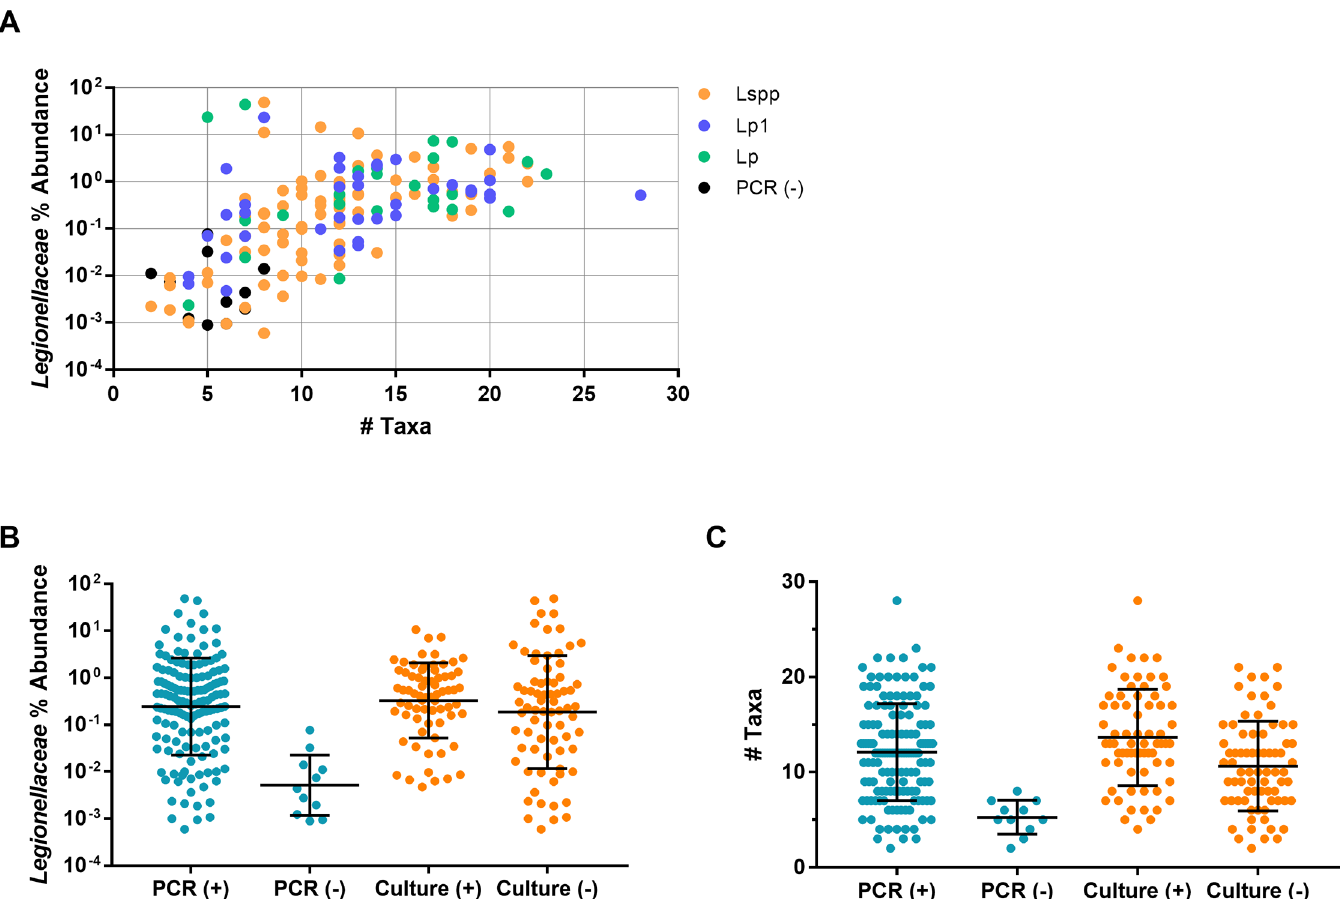
Fig 3. Samples with higher diversity of taxa correlate with higher levels of Legionellaceae abundance. PCR positive samples were analyzedby 16S rRNA ampliconsequencing and the relative Legionellaceae abundance of each was comparedto the number of bacterial families (relative abundance > 1%) detected and organized by initial sample multiplexPCR result (A). The relative Legionellaceae abundance (B) and numberof taxa (C) of samples that were positive or negativefor multiplexPCR and culture were analyzed.Bars represent the geometric (B) or arithmetic (C) mean and error bars indicatestandard